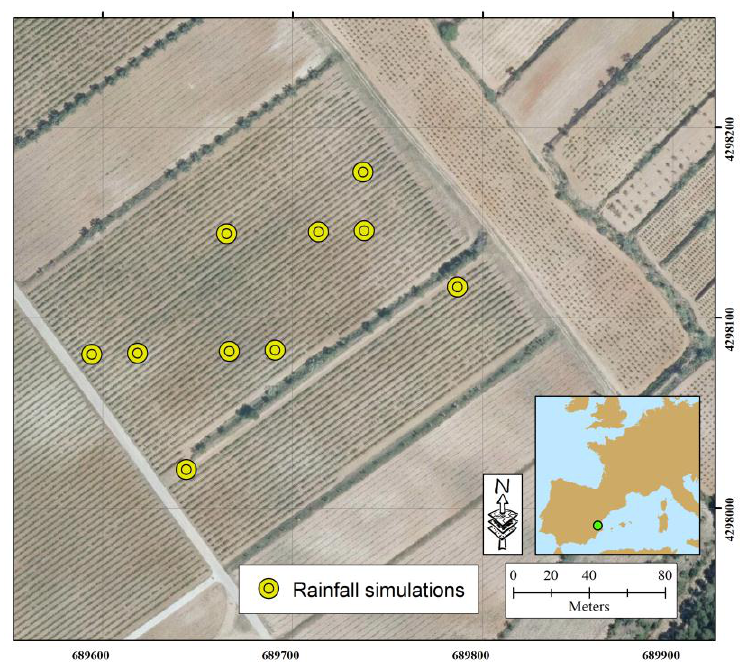
Figure 1. Study area (Celler del Roure, Valencia, Spain). Yellow symbols represent the location of each rainfall simulation experiment.